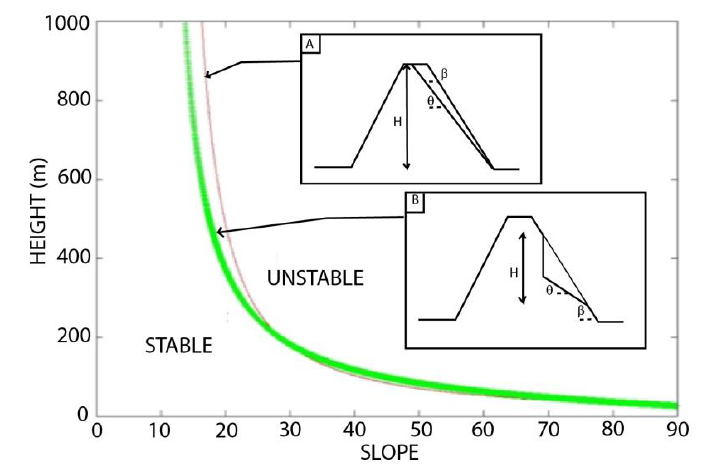
Figure 2. Effect of the initial slope β on the maximum stable relief H for two different landslide geometries. ( A ) Cullman wedge model, ( B ) concave geometry model. ρ c = 3000 kgm −3 , C = 1 MPa, ϕ = 10 0 .